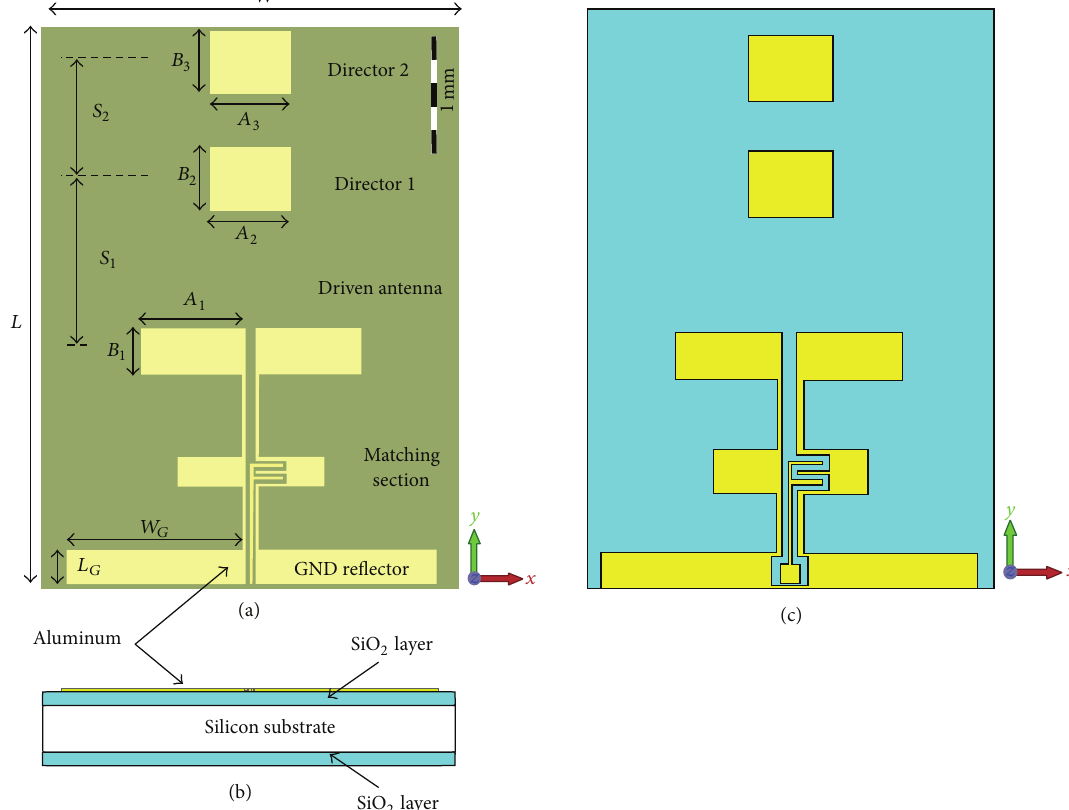
Figure 6: Geometrical configuration and photograph of the fabricated Quasi-Yagi dipole antenna prototype II: (a) top view, (b) side view, and (c) schematic diagram of the designed antenna with a